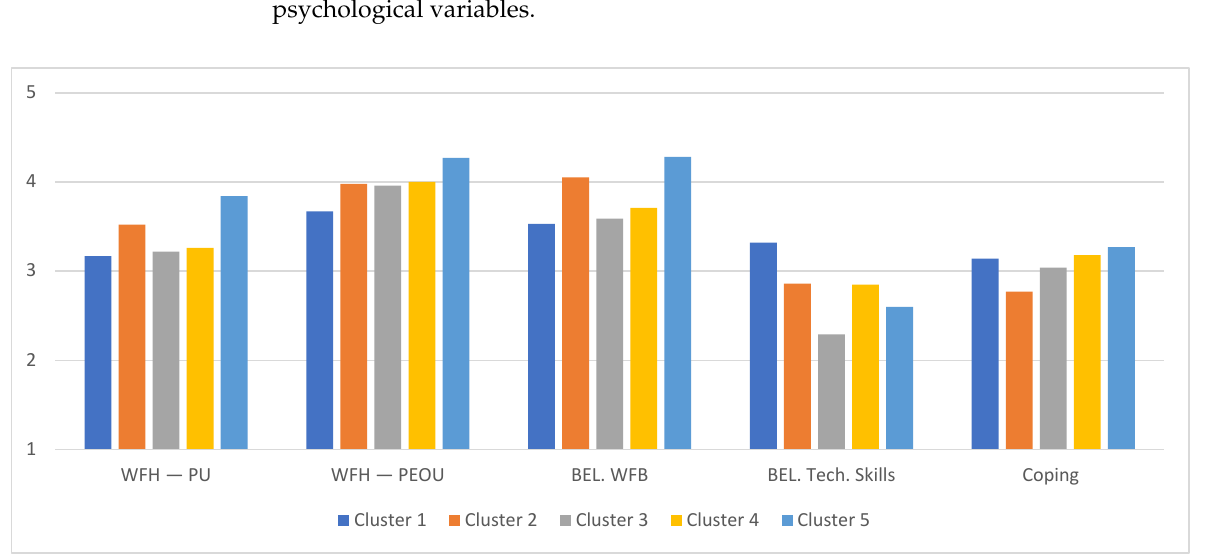
Figure 1. Clusters comparisons on WFH acceptance, remote working attitudes, and coping .